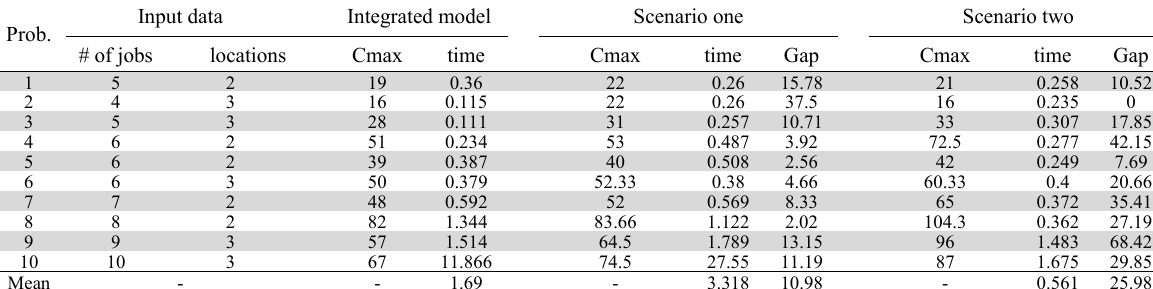
The results of the optimal solution for 10 sample test problems